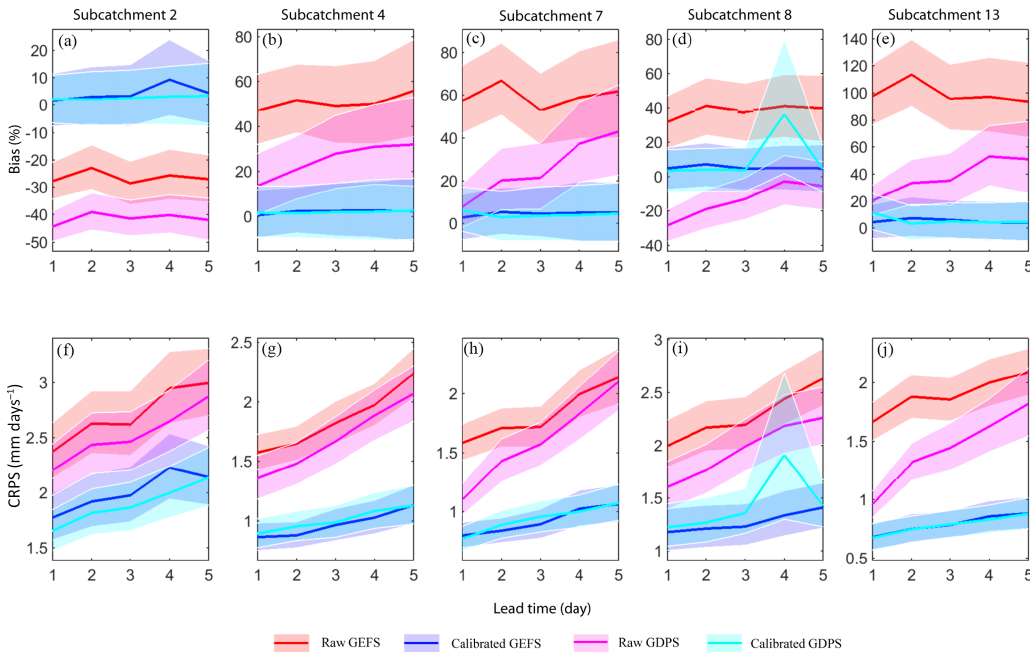
Figure 3. Subcatchment-averaged bias (%) in the raw QPFs and calibrated QPFs for individual daily forecasts as a function of lead time for subcatchments 2, 4, 7, 8, and 13 ( a–e , respectively); panels (f–j) show subcatchment-averaged CRPS (mmday − 1 ) in the raw QPFs and calibrated QPFs for daily precipitation as a function of lead time. The shaded region represents 5 and 95% confidence intervals generated using a bootstrap approach. Note the different scales on the vertical